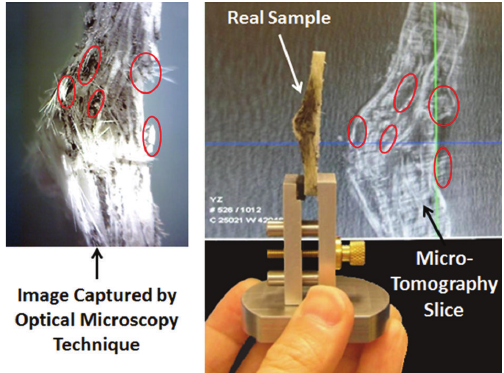
Figure 3: Comparison between the real impacted sample and the images obtained from nondestructive microtomography and destructive optical microscopy; red circles are to show comparable damage zones captured by the two